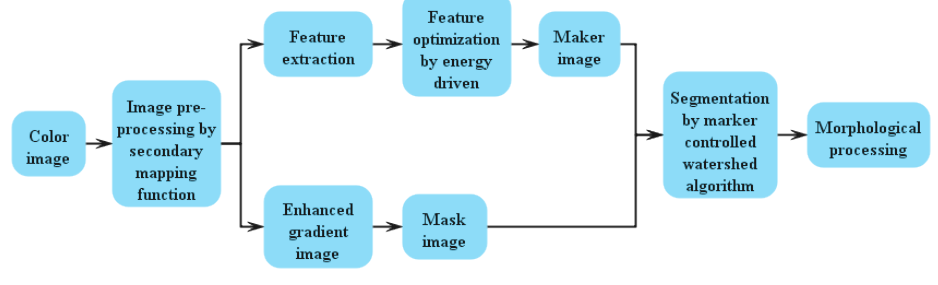
Figure 1. Overall